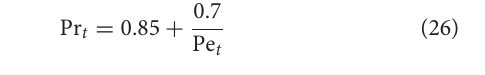
number in the near wall region is highly related to the local turbulent Peclet number non-linearly (Kawamura et al., 1999; Tiselj and Cizelj, 2012; Duponcheel et al., 2014), and there is no universal correlation for the localized turbulent Prandtl number in the near wall region so far (Grötzbach, 2013; Roelofs et al.,